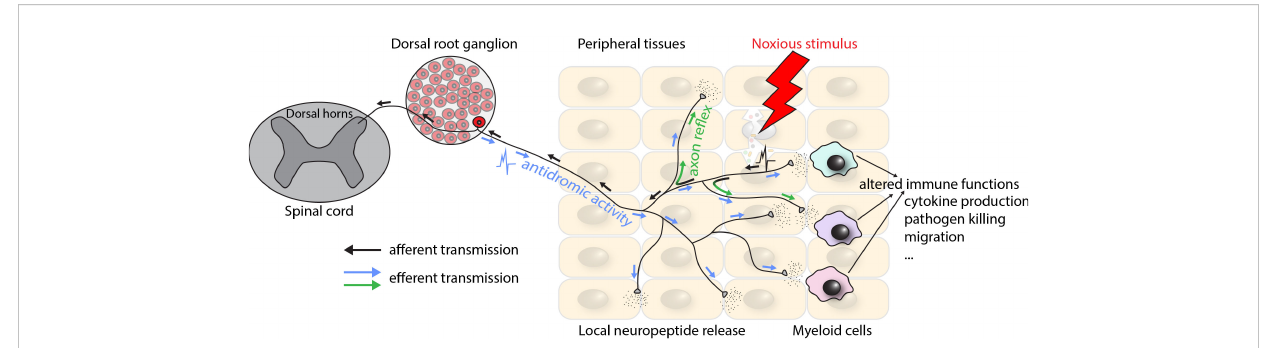
FIGURE 1 Schematic depiction of the physiological organization of and signal transmission by nociceptors. Arrows indicate the direction of action potential propagation. Black arrows correspond to the afferent transmission of signals elicited by peripheral activation of nociceptors by a noxious stimulus, terminating in the spinal cord and leading to the sensation of pain or itch. Blue and green arrows correspond to the efferent transmission by means of antidromic activity (conduction in the reverse direction) and axon re fl ex (backpropagation of the action potential through collateral branches) respectively, leading to the peripheral release of